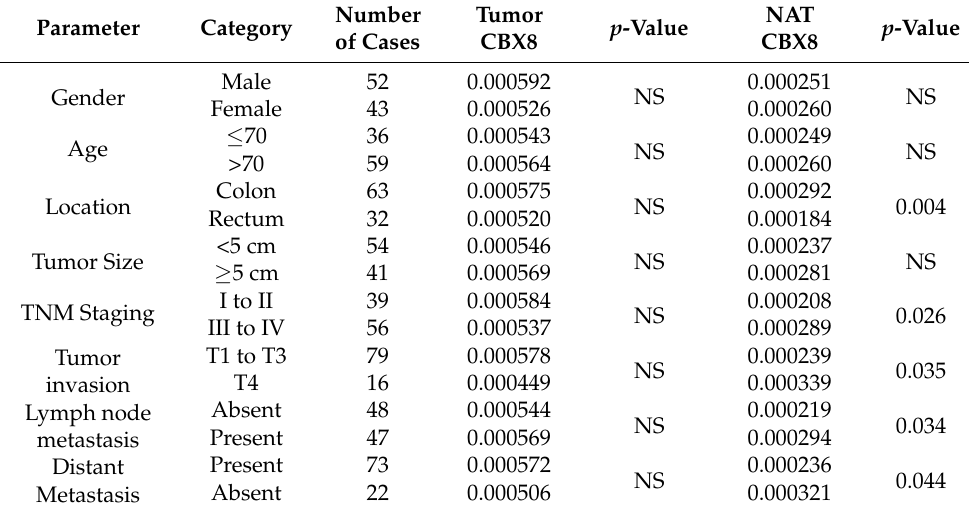
Table 1. Clinicopathological correlation of CBX8 level in Tumor and NAT specimens of 95 CRC